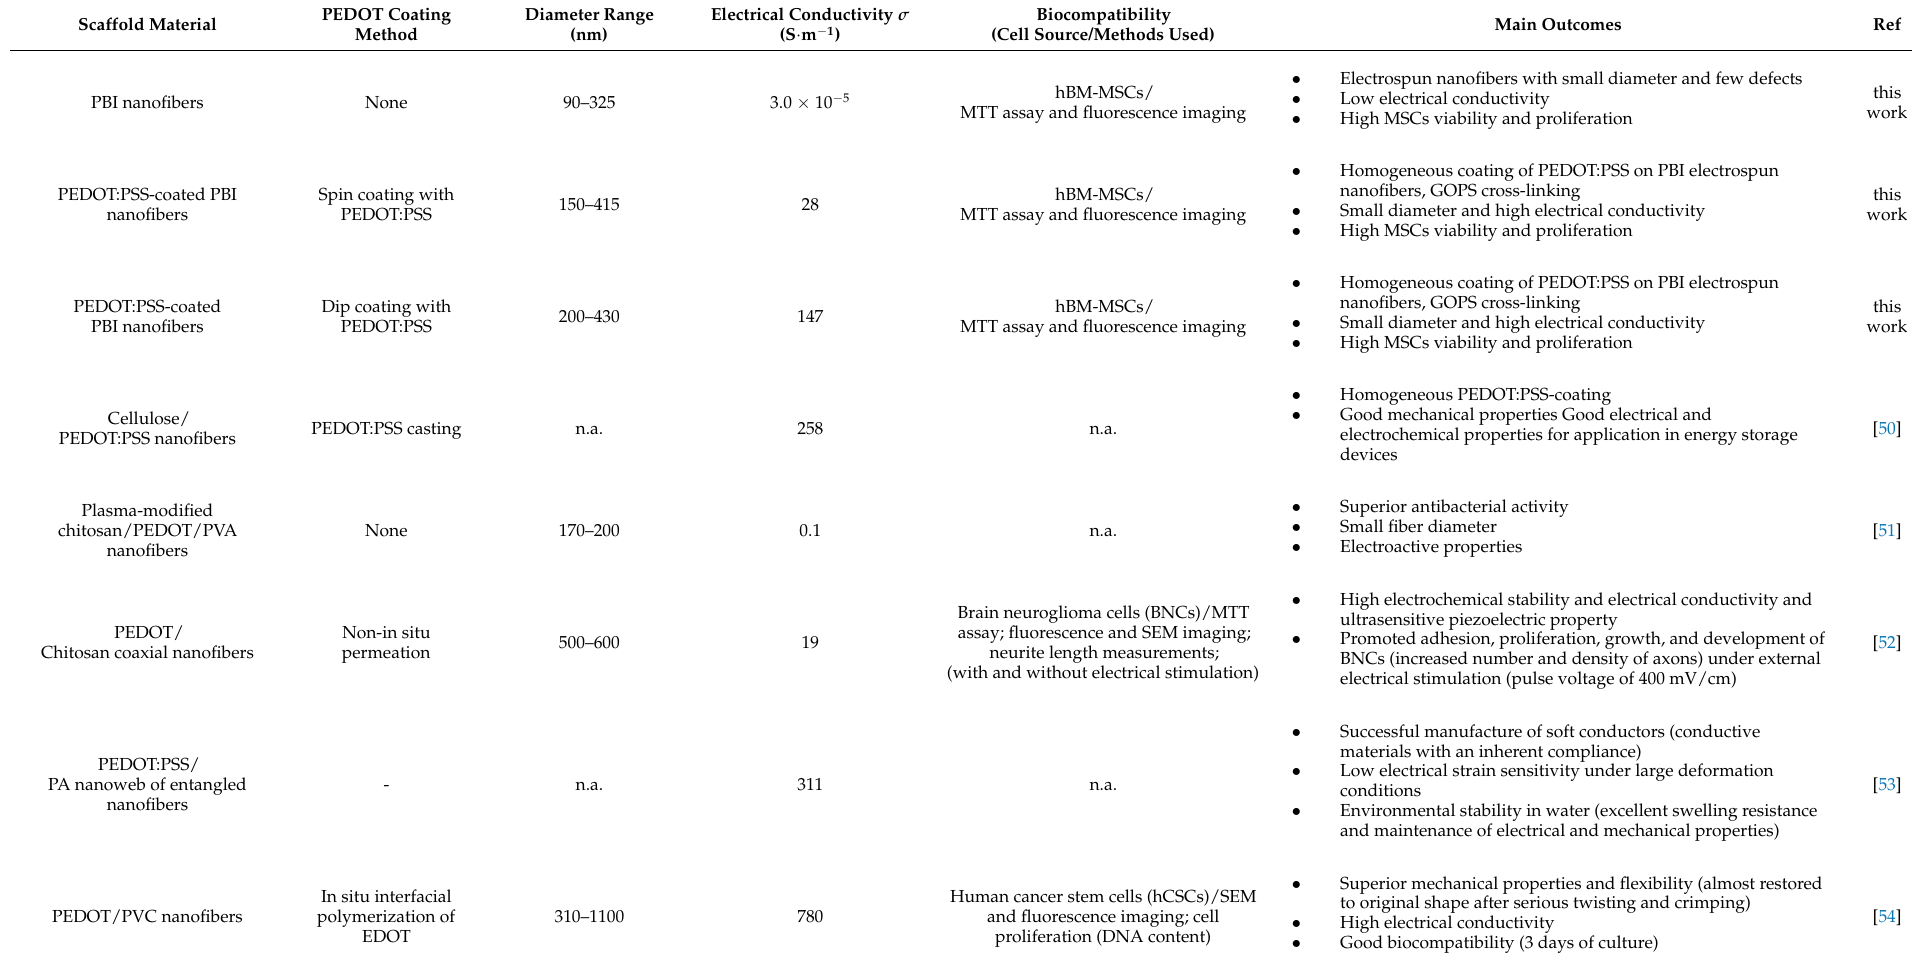
Table 1. Comparison of the electrical conductivity and average fiber diameter values between the nanofibers studied in this work and other PEDOT-containing nanofibers previously reported in the literature. Abbreviations: BC—bacterial cellulose; PA—polyacrylamide; PVA—polyvinyl alcohol; PVC—polyvinyl chloride; PVP—polyvinyl pyrrolidone; n.a.—Not